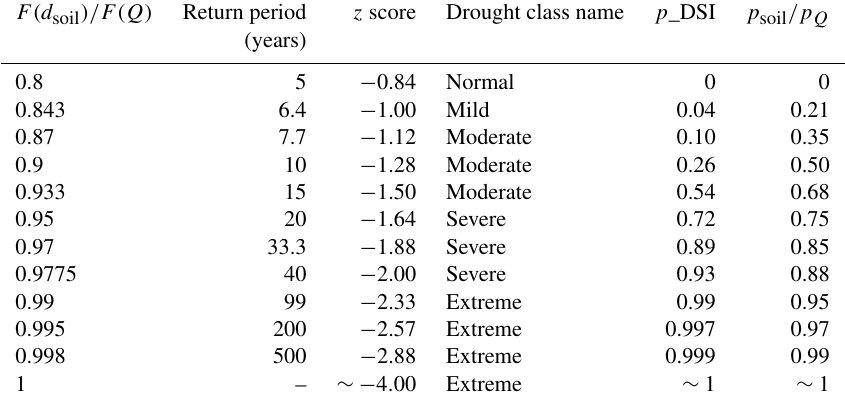
Table 1. Relationship of the anomaly component p of SMDAI and QDAI to the non-exceedance probability of the soil moisture deficit (F(d soil )) or of streamflow ( F(Q) ), the pertaining return periods, z scores and class names according to Agnew (2000) as well as the p values by Cammalleri et al. (2016) to compute DSI. The class name refers to the drought conditions with z -score values that are larger than those listed in the z -score column. The equiprobability transformation technique, first suggested by Abramowitz and Stegun (1965) and utilized in Kumar et al. (2009) for calculation of the standardized precipitation index (SPI), is used to back-calculate F values from the z -score values.